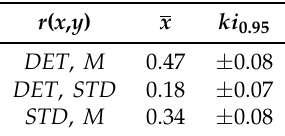
Table 1. Statistical analysis coefficient of